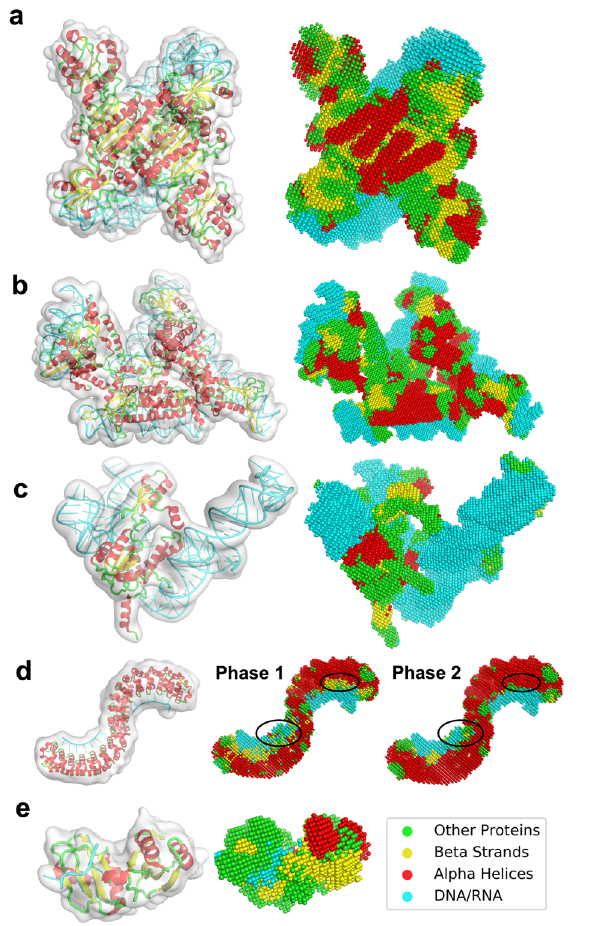
Fig. 3 Example of the structure detection for simulated maps. For each panel, the macromolecular structure in the simulated EM map is shown on the left while the structure detection result of the phase 2 network is shown on the right. Colors of spheres in the structure detection panels indicate structure types: red α helices; yellow, β strands; green, other structures (loop); and cyan, RNA/DNA. Detailed evaluation metrics are included in Supplementary Data 1. a Aspartyl-tRNA synthase complexed with tRNA (Asp) (PDB ID: 1IL2. Simulated map resolution: 6 Å. The complex contains 1170 amino acids (AA) and 129 nucleotides (nt). Voxel-based F1 score (F1): 0.879; Voxel-based accuracy (Acc): 0.880; Q4: 0.842. b Large serine recombinase (LSR) – DNA complex (PDB ID: 4KIS. Simulated at 7.56 Å. 1216 AA and 208 nt. F1: 0.864; Acc: 0.863; Q4: 0.867. c Ribosomal